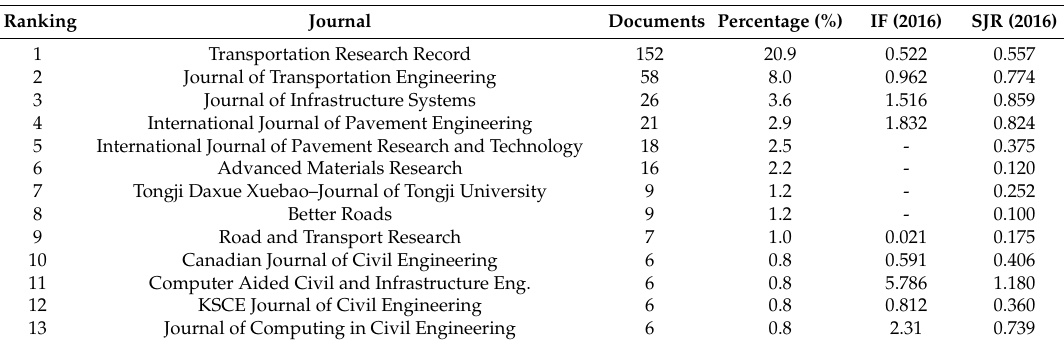
Table 6. The top most productive